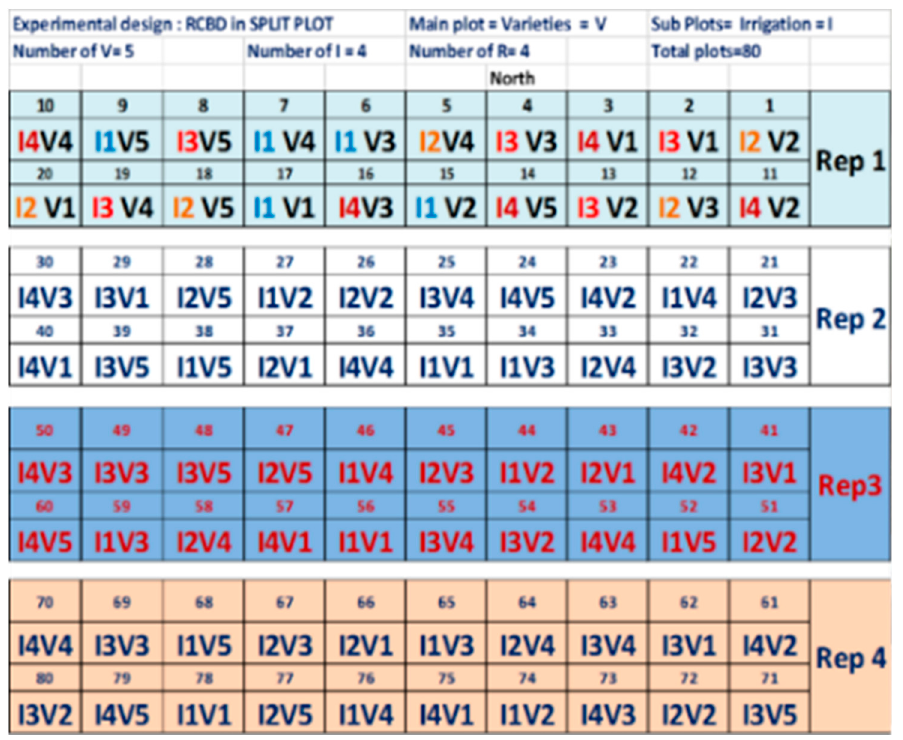
Figure 3. Field layout of the randomized complete block experimental design (RCBD), 4 × 5 × 4, employed in 2018 (I = irrigation interval, V = variety, Rep = replications, and numbers = plot numbers). Irrigation intervals are: I1 = 7 days (control); I2 = 10 days; I3 = 13 days; and I4 = 15 days. Bean Varieties are: V1 = black; V2 = white; V3 = motley; V4 = pied; and V5 = red.